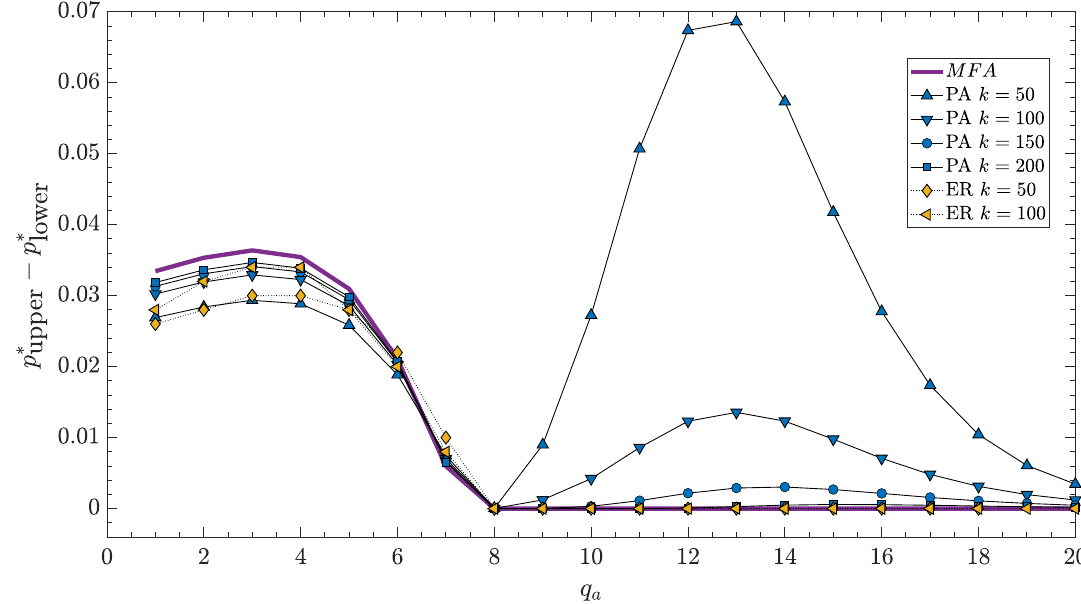
Figure 4. The width of the hysteresis, defined as the distance between the upper and the lower spinodal, as a function of q a for q c = 10 within MFA, PA and MC simulations on ER graphs (indicated as ER in the legend). Thin black lines are just a guide to the eye.